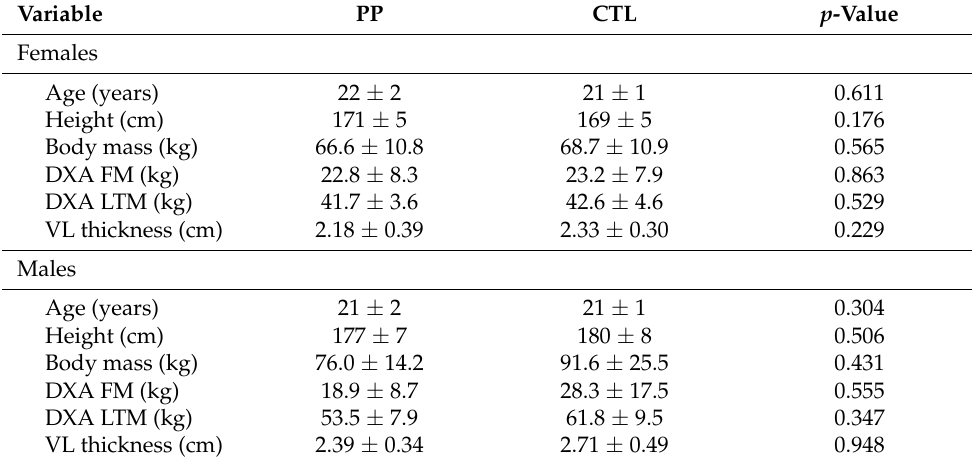
Table 2. Participant baseline